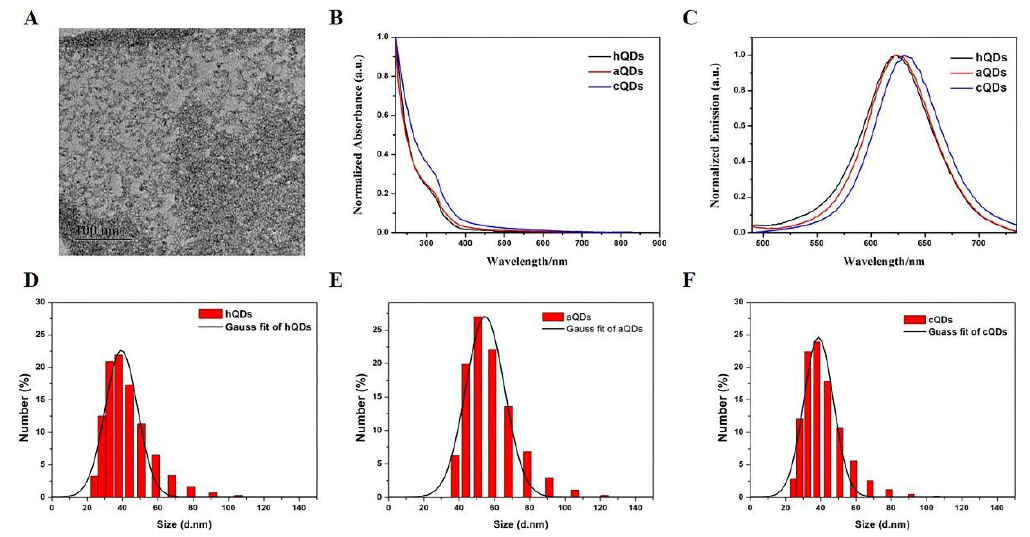
Figure 1. Characterization of three InP/ZnS QDs with different surface modifications. ( A ) TEM image of InP/ZnS QDs dispersed in toluene. ( B ) Normalized absorption spectra of hQDs, aQDs and cQDs. ( C ) Normalized PL spectra of hQDs, aQDs and cQDs recorded at room temperature in a 1 cm quartz cuvette ( λ ex = 380 nm). ( D ) The hydrodynamic diameter of hQDs dispersed in deionized water. ( E ) The hydrodynamic diameter of aQDs dispersed in deionized water. ( F ) The hydrodynamic diameter of cQDs dispersed in deionized water.